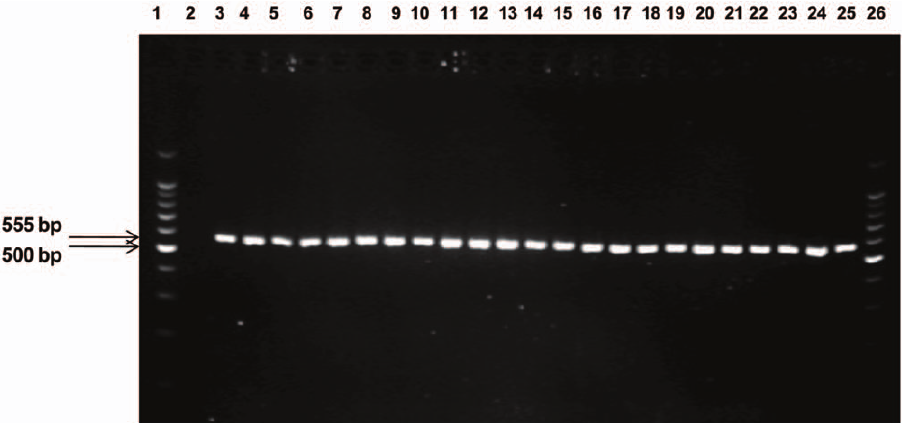
Figure 1. Amplification of S.wadsworthensis DNA from reference and clinical strains using the SW-F and SW-R primers. The assay amplified a product of < 555 bp in size. Lane 1:100 bp marker, Lane 2: negative control (no DNA), Lane 3: S. wadsworthensis DSM 14016, Lane 4 – Lane 25: S. wadsworthensis isolate SW1, SW2, SW4, SW5, SW6, SW7, SW8, SW9, SW10, SW11, SW12, SW13, SW14, SW15, SW16, SW17, SW18, SW19, SW20, SW21, SW22, SW23, Lane 26:100 bp marker.